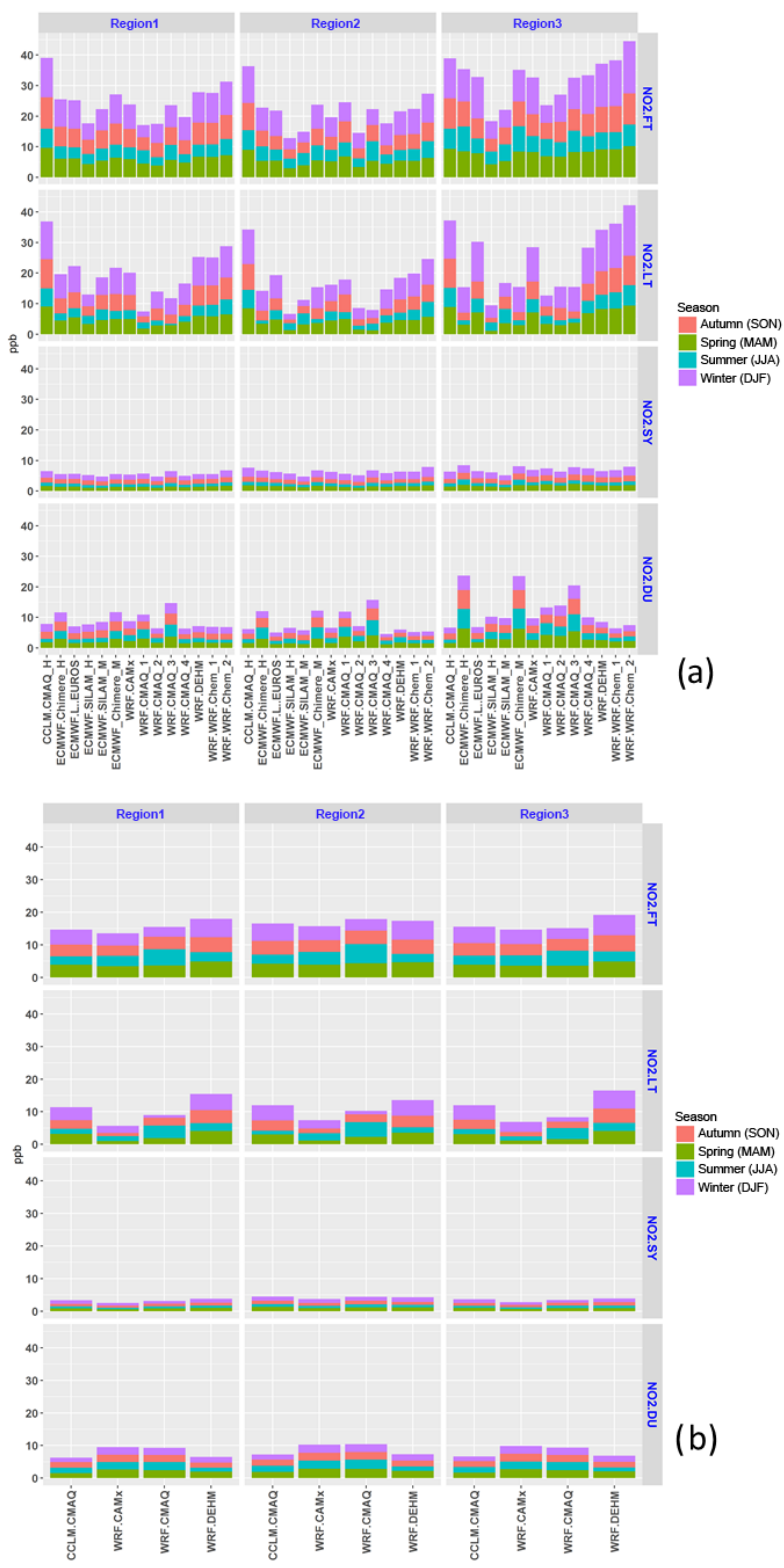
Figure 14. As in Fig. 9 but for NO 2